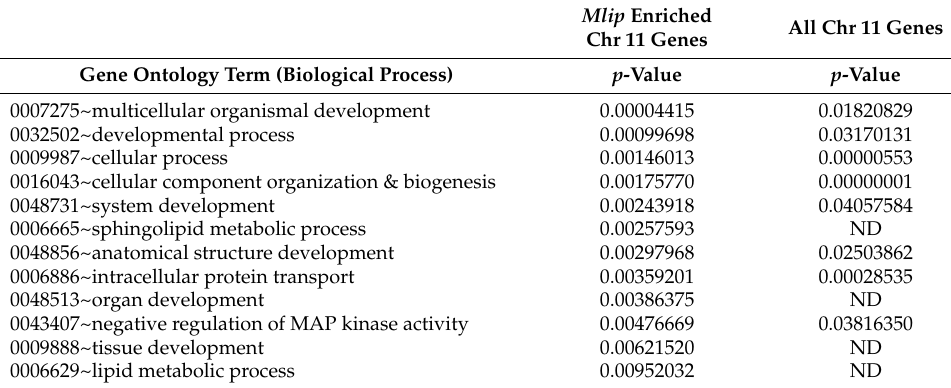
Table 2. Biological processes enriched for on mouse chromosome 11 by Mlip mediated chromatin im-